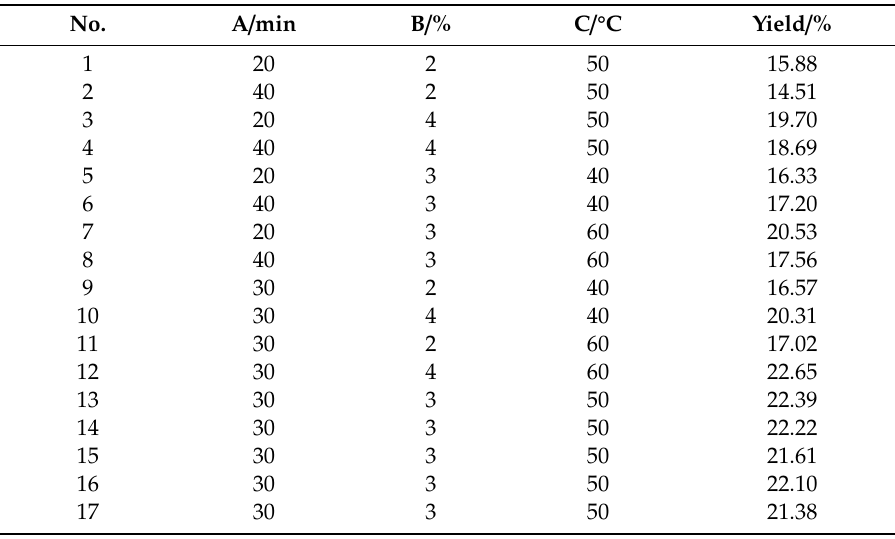
Table A2. Response surface design and experimental